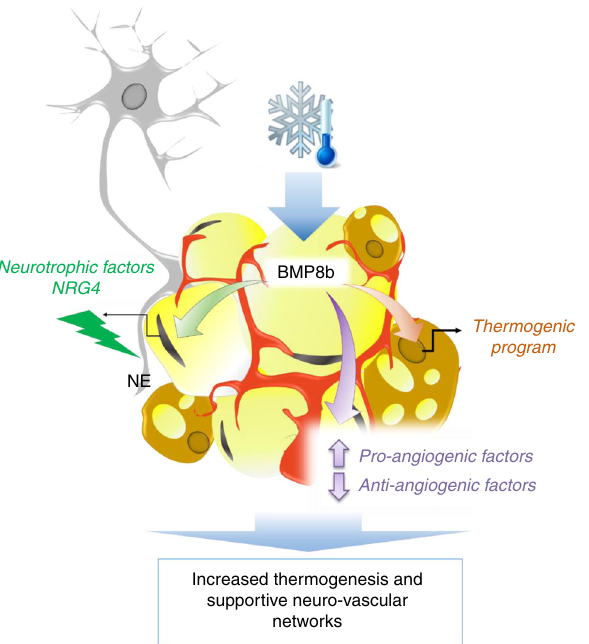
Fig. 9 Summary of proposed roles of Bmp8b in AT. BMP8b overexpression in adipocytes and subsequent hyper-activation of the sympathetic tone induce the recruitment of thermogenic beige adipocytes in ScW which